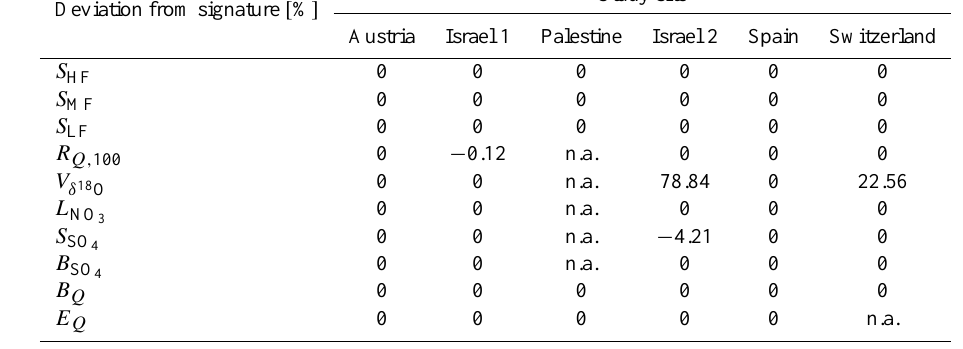
Table 6. Agreement of modelled with observed signatures (Table 5) in model evaluation stage 1. Deviation from signature [ % ]